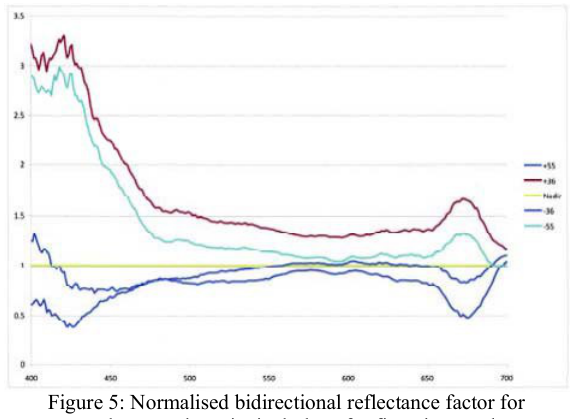
Figure 5: Normalised bidirectional reflectance factor for corymbose - solar principal plane for five view